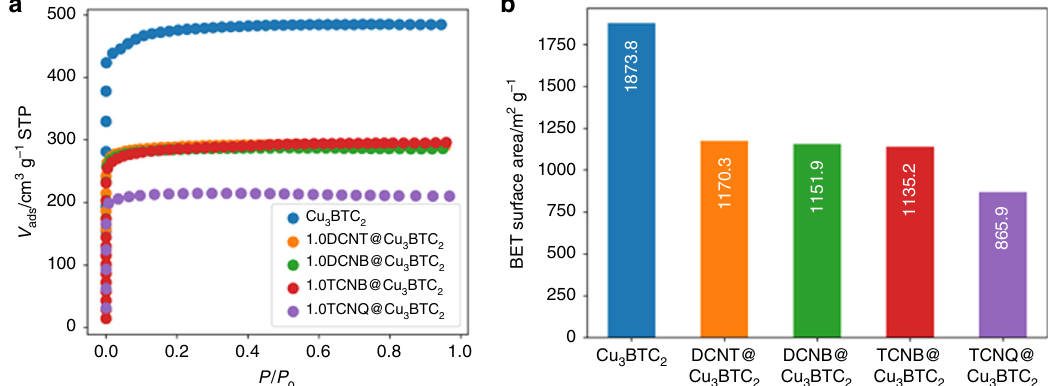
Fig. 6 Porosimetry measurements of CL@Cu 3 BTC 2 . Nitrogen adsorption isotherms a and calculated BET surface areas b for samples with CL = DCNT (orange), DCNB (green), TCNB (red), and pristine Cu 3 BTC 2 (blue). All new materials show a high residual porosity after the retro fi tting